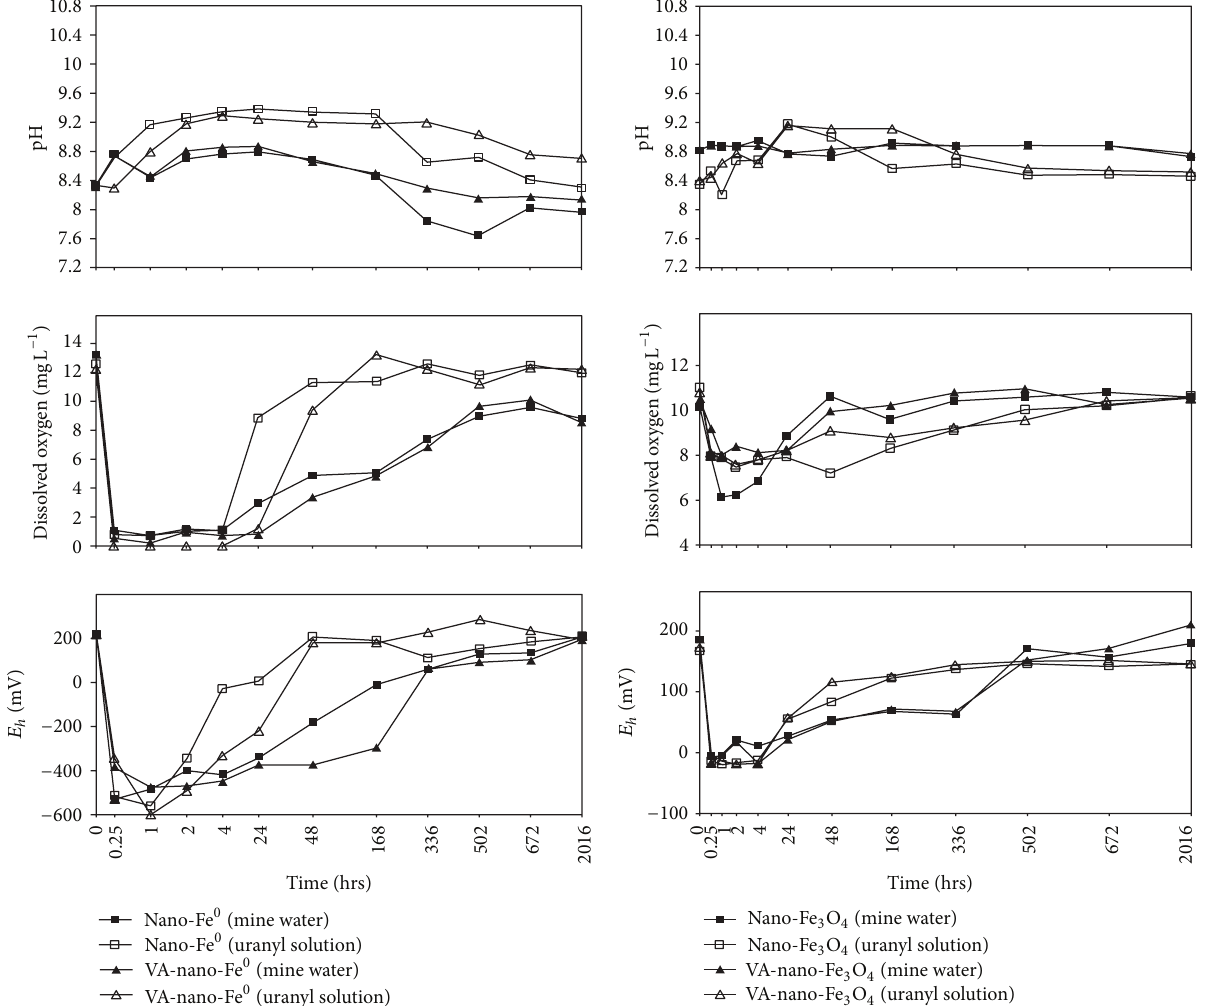
Figure 4: Solution pH, dissolved oxygen and Eh as a function of reaction time (0–2016